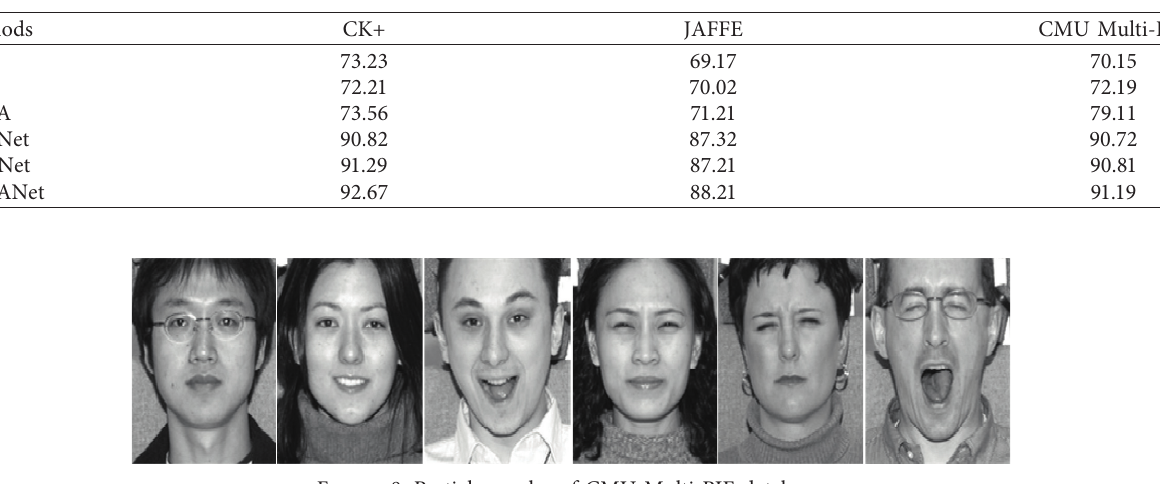
Figure 7: Sample facial images from the JAFFE dataset. Table 1: Experiment results of different methods.